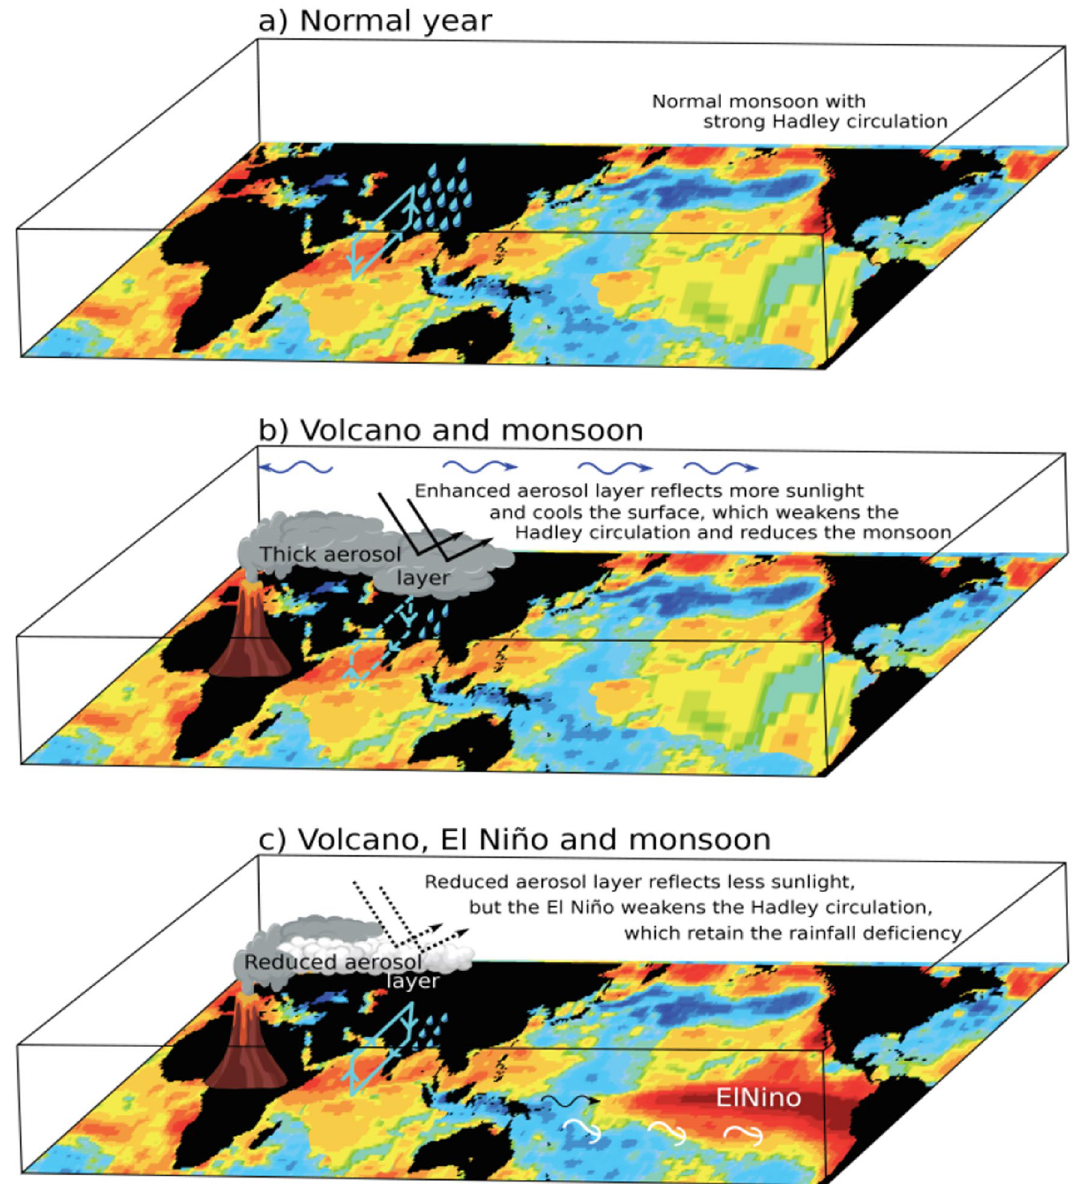
Figure 7. A schematic of the impact of volcanic eruptions on monsoon precipitation: ( a ) normal monsoon with a strong Hadley circulation, ( b ) Nabro volcanic aerosol leading to a thick aerosol layer in the UTLS comprising of the ATAL, which reflects more solar radiation leading to a weak Hadley circulation (anomalous; denoted with sign reversal and dotted lines) and a reduction in rainfall. ( c ) The tropospheric cooling induced by the thicker ATAL (as in volcano year, " b ") induces an El Niño in the following year (through anomalous atmospheric Kelvin and Rossby waves (shown as a blue wave in “ b ”), which induce a westerly wind burst (black wave) and produce an El Niño through downwelling Kelvin waves (shown in white colour)). However, the reduced aerosol layer lets pass more sunlight compared to the year of the eruption, but the El Niño weakens the Hadley circulation (anomalous; shown in lines [since it is less reduction than in the year of the eruption] with the inverted arrow) and retains the deficit rainfall condition. The SST patterns intend to indicate the normal and El Niño condition over the Pacific, rest of the oceanic basins are kept the same in all maps for illustration purpose (and are not connected with our simulations). Maps are prepared using NCL and 3D impact and schematic structures made utilizing Adobe